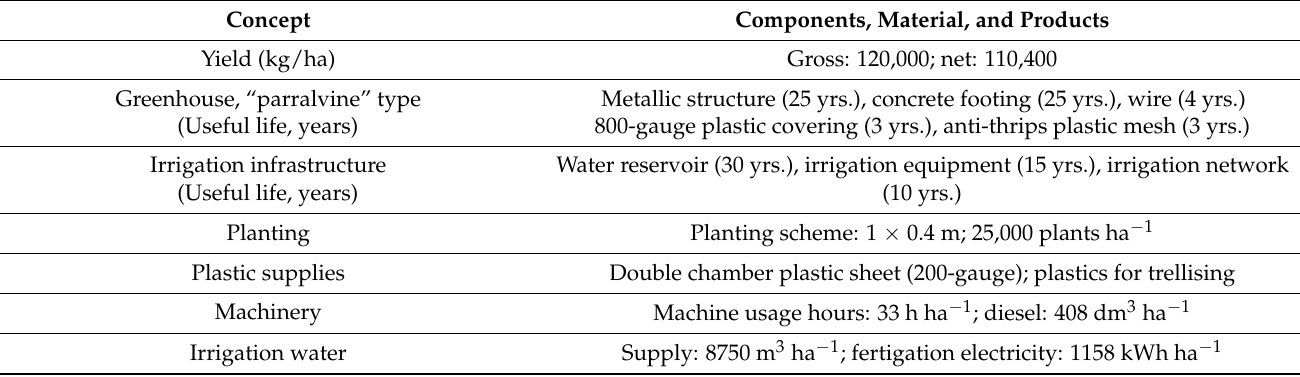
Table 1. Characteristics of greenhouse pepper cultivation in Campo de